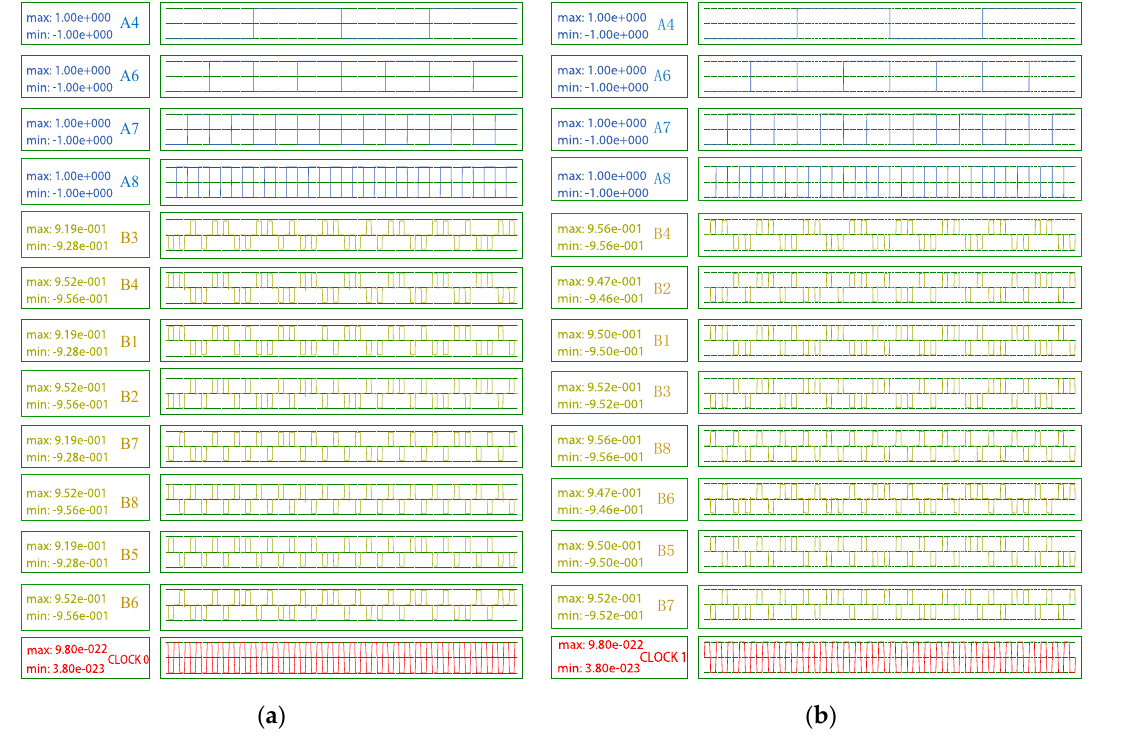
Figure 21. The QCA implementation of the proposed G(8, 4) circuits. ( a ) the first G(8, 4) and ( b ) the second G(8, 4).